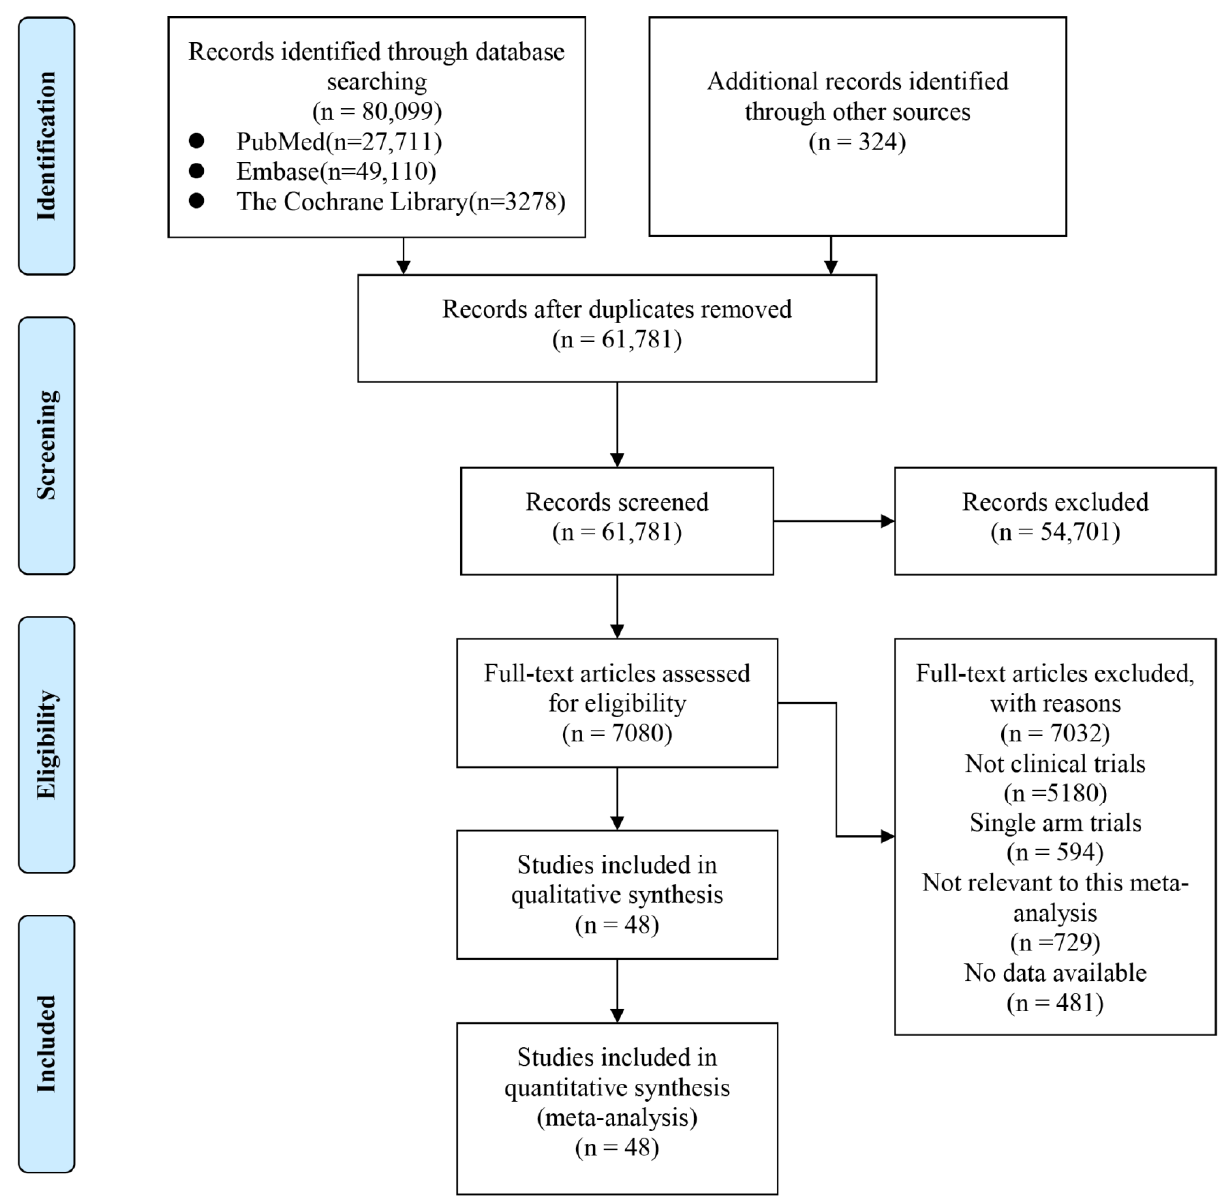
Figure 1. Flow chart of study selection.